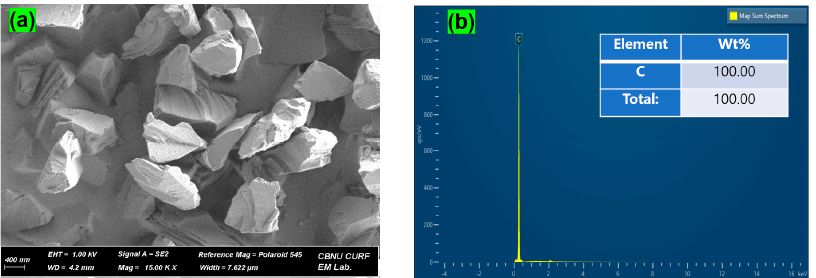
Figure 3. Diamond abrasive particles: ( a ) SEM image of diamond particles (1 µm × 15,000) and ( b ) EDS analysis.